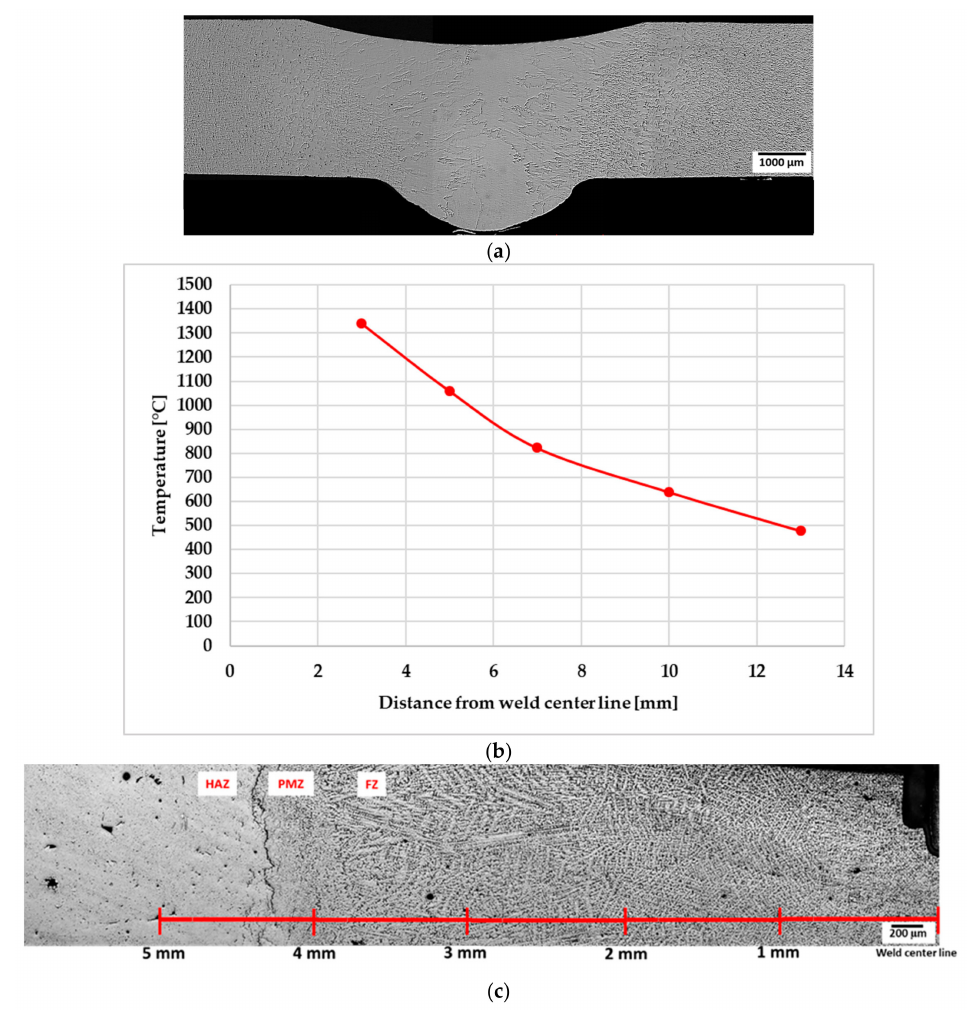
Figure 7. ( a ) Cross section of a welded sample; ( b ) peak temperatures as a function of distance from weld center line; and ( c ) fusion zone (FZ), partially melted zone (PMZ), and heat a ff ected zone (HAZ) of the welded sample, and the distance of these zones from the weld center